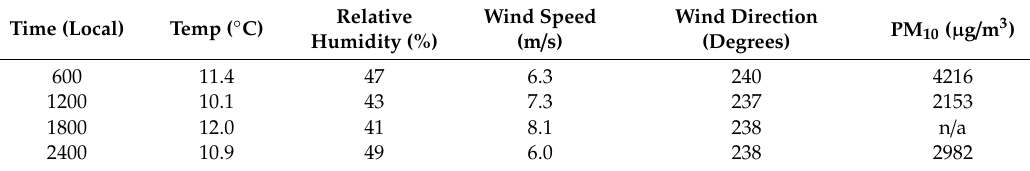
Table 3. Surface meteorological conditions in Be’er Sheva on 12 December 2010.